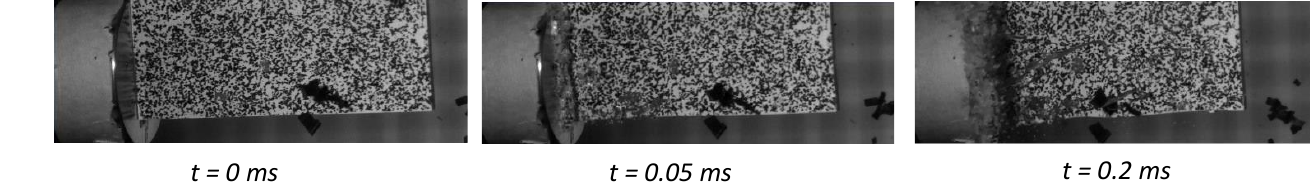
Fig. 5. Impact experiment of PMMA fragment launched at